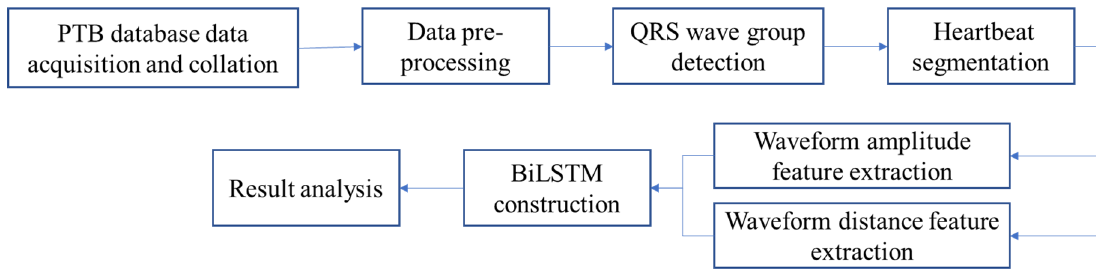
Figure 1. Algorithm flow diagram.